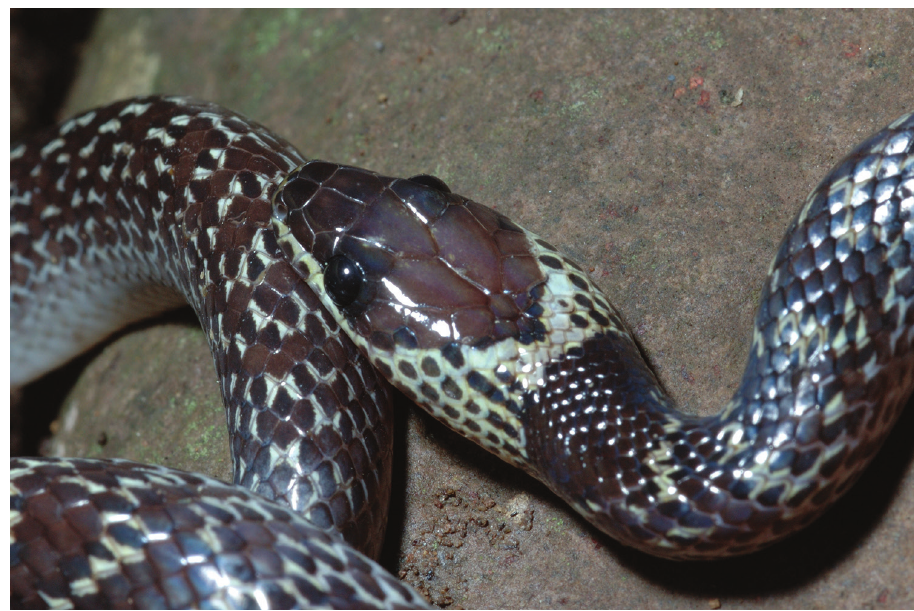
Figure 68. Lycodon capucinus (KU 305142) from Barangay Cabuan, Municipality of Guinsiliban, Cami- guin Sur Island. Photo: